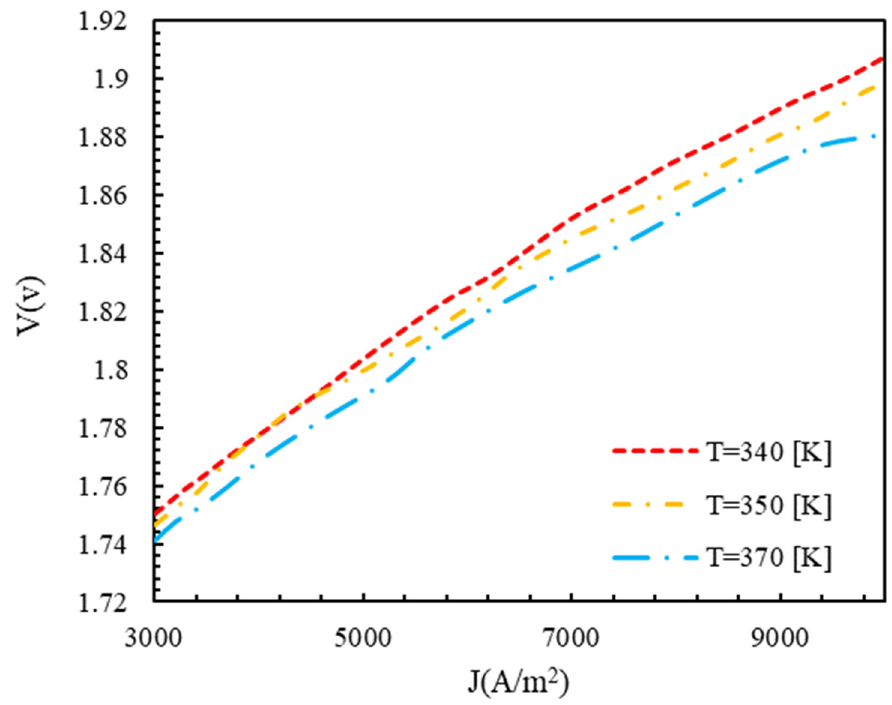
Figure 6. Polarization curve of polymer membrane electrolyzer at different temperatures with P = 1 bar, electrode catalyst of platinum, and membrane of Nafion.